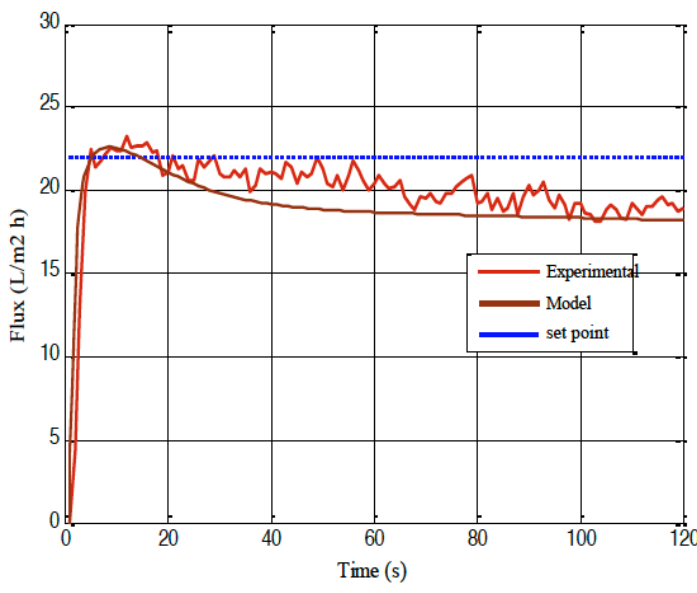
Figure 12. Model and real-time open-loop flux responses for constant input voltage .